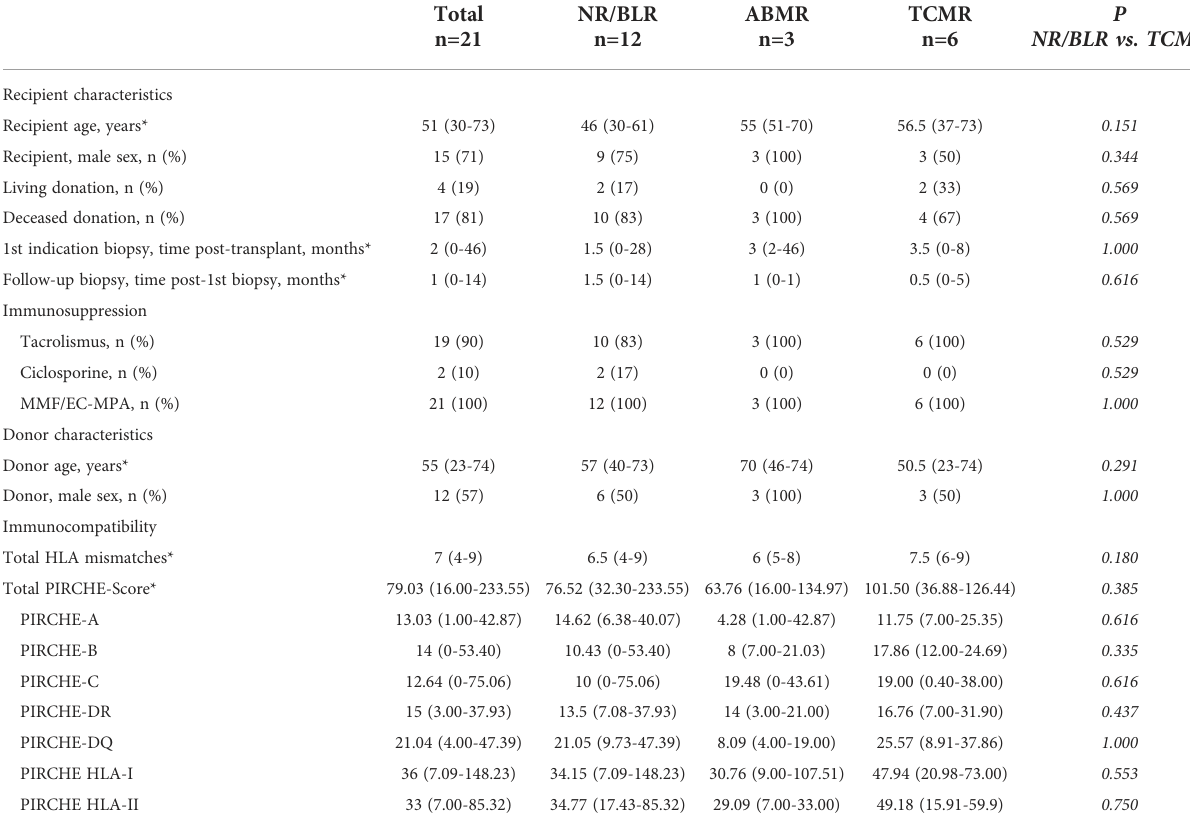
TABLE 2 Basic characteristics of 21 KTRs with TCMR in the fi rst indication biopsy and grouping based on the results of the follow-up